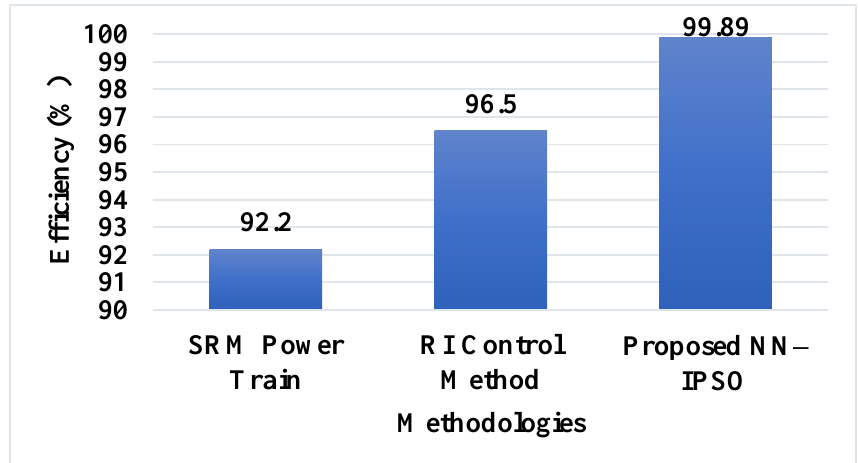
Figure 12. Comparative analysis of existing methods [25,26].